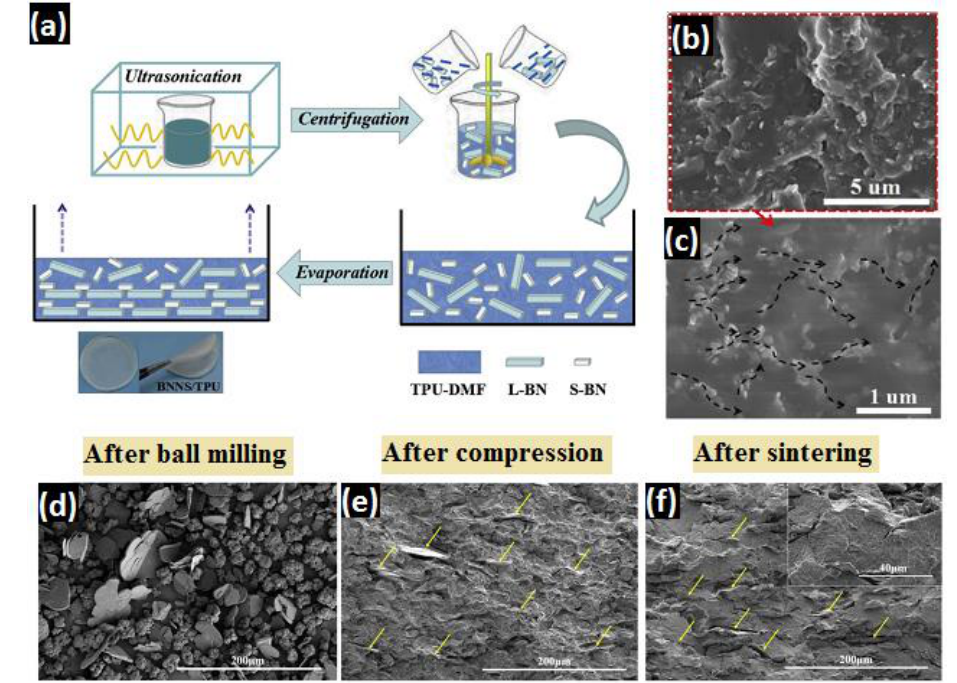
Figure 4. ( a ) Schematic illustration of self-assembly evaporation of flexible L and S-BNNSs / TPU composite, ( b , c ) SEM images of 10 wt.% BNNSs / TPU (Reprinted with permission from Elsevier,